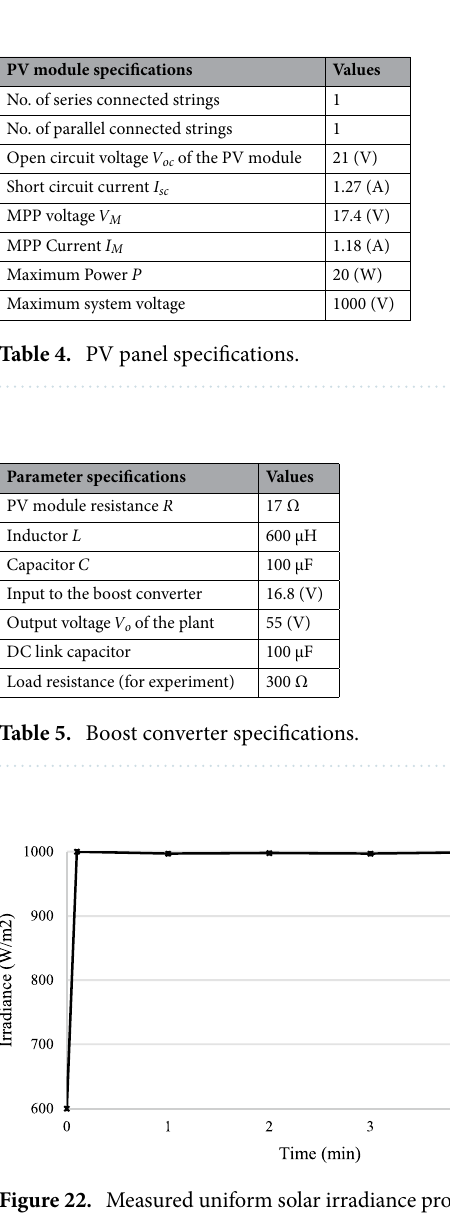
Table 3. Hardware specifications.